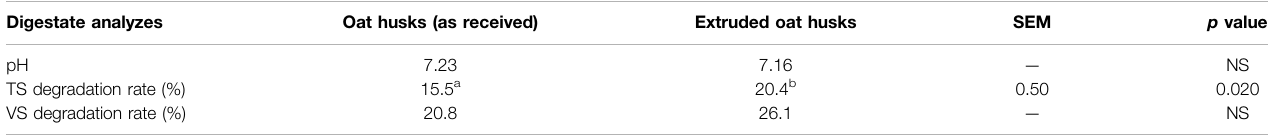
TABLE 4 | The effect of the BioExtruder pre-treatment technology on the mean pH, total solids (TS) and volatile solid (VS) degradation rates (%) (VS is expressed as a proportion of TS content) at the end of the biochemical methane potential assays. Digestate analyzes Oat husks (as